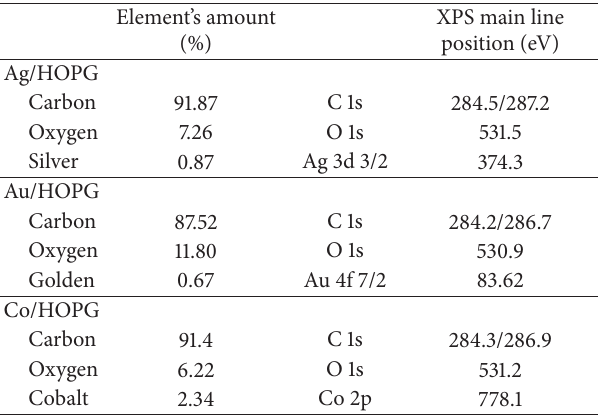
Figure 2: Histograms of particle dimensions distribution for each nanoparticle on HOPG surfaces obtained processing the AFM images by Nanoscope software (Bruker).